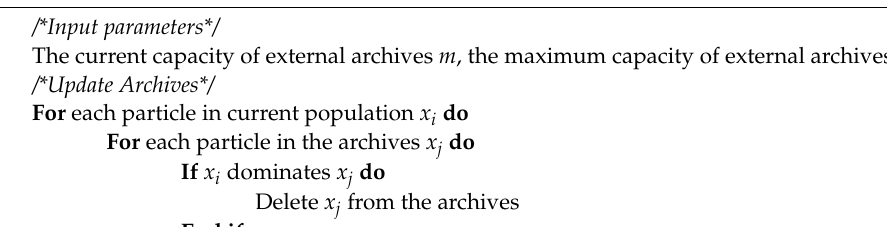
Algorithm 2. Steps of updating external